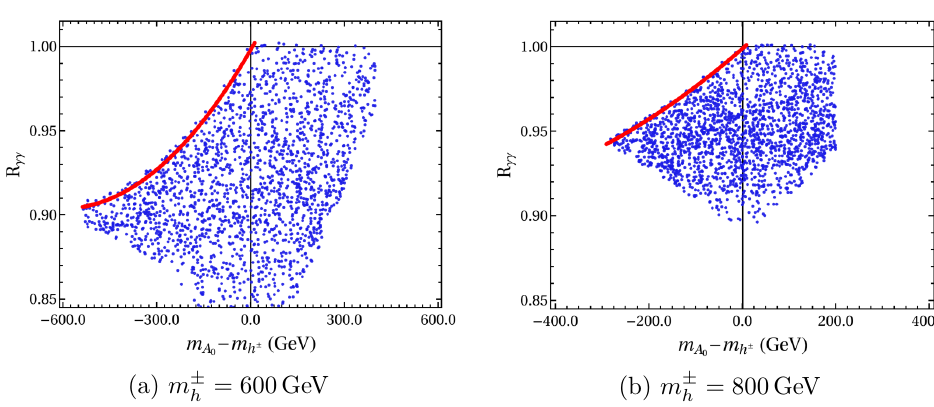
Figure 6 . Ratio R γγ as a function of the difference in mass among A 0 and the charged scalar h ± . Each plot corresponds to a different choice of m ± . In all plots, blue points correspond to the 2HDM h while red points correspond to the 3-3-1 effective